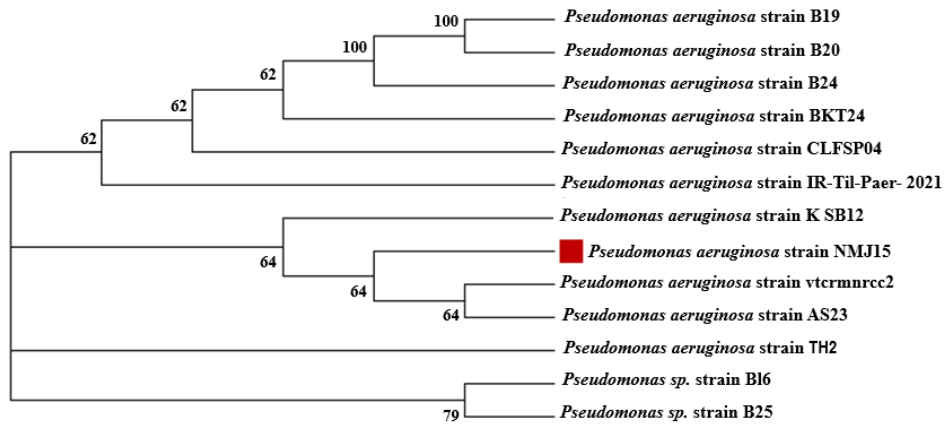
Figure 1. Phylogenetic tree of the 16S rRNA sequences of bacterial strain NMJ15 isolated from mangrove sediment. The analysis was achieved by MEGA 6, which used the neighbor-joining approach with a bootstrap value (1000 replicates).